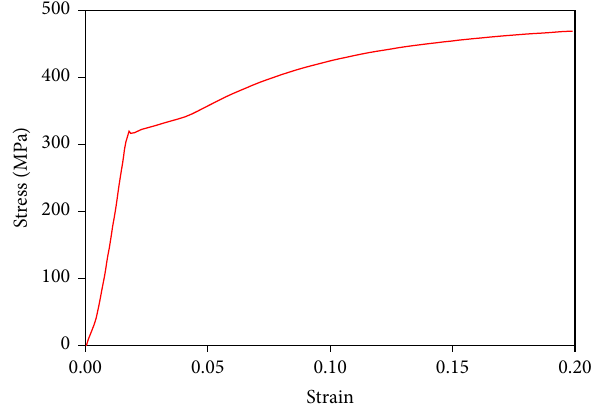
Figure 6: Stress–strain